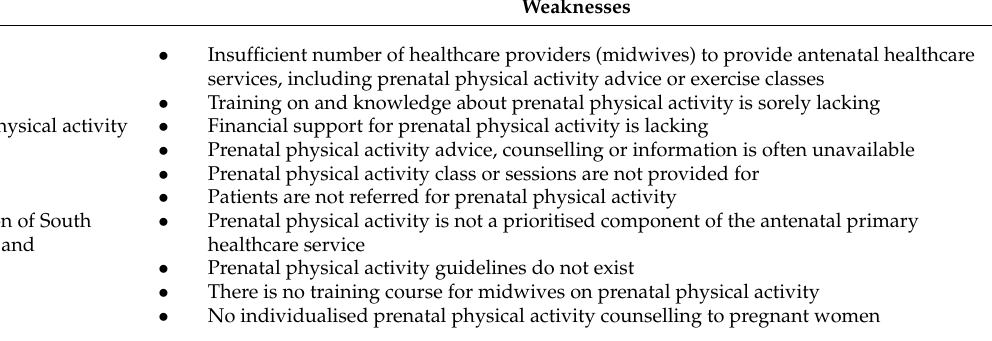
Table 1. The BOEM strategy from the SWOT analysis of prenatal physical activity among women in the Eastern Cape.